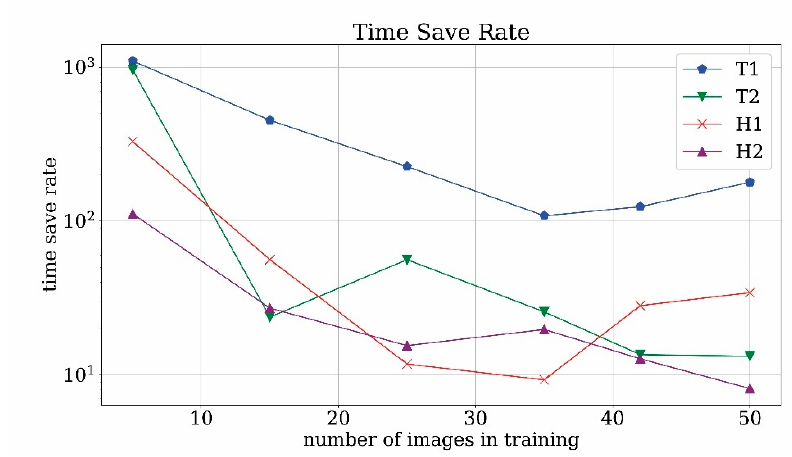
Figure 22. Time Save Rate analysis.